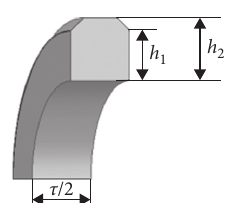
Figure 6: Physical model of CPMS.